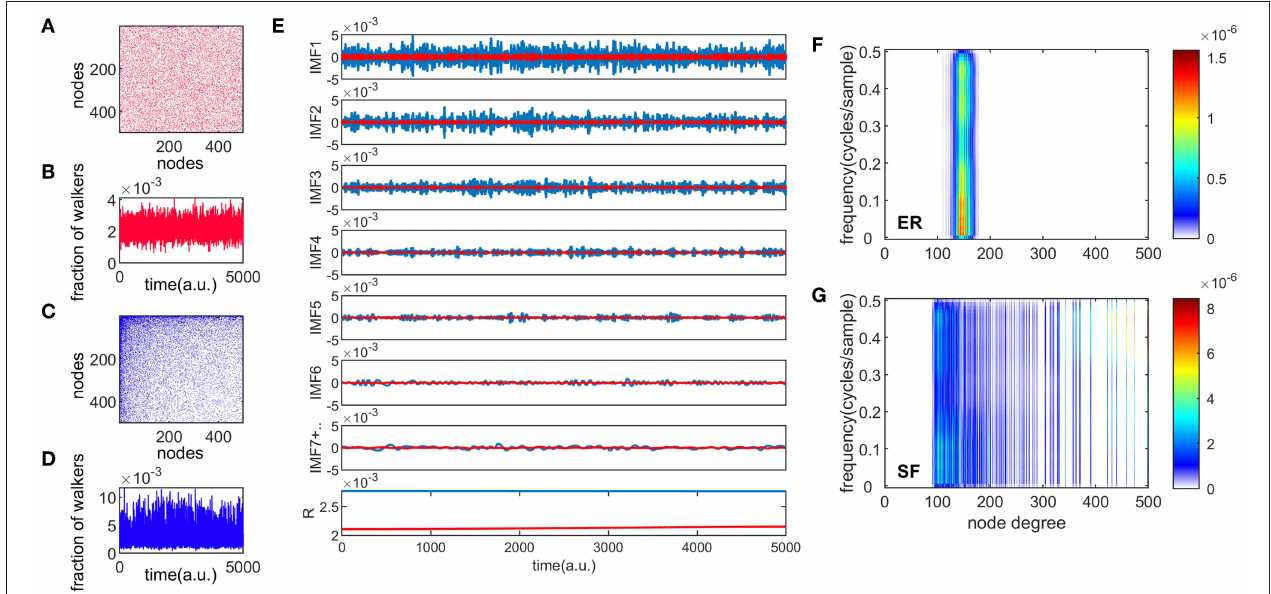
FIGURE 1 | Different temporal modes of information flow in complex networks. Panels (A,C) are examples of ER and SF connectivity matrices, respectively, with N = 500 and e = 0.9. Panels (B,D) show one realization of the information flow in the network for 5000 time steps, for ER and SF networks, respectively. The total number of walkers present in each network was 10 4 . Panel (E) shows the empirical mode decomposition (EMD) of the time series in panels (B,D) , producing different intrinsic mode functions (IMF), and a residue (R). This appears in red (blue) for the ER (SF) networks. Panels (F,G) show the spectrum of the random walk process organized by the node degree for ER and SF networks,